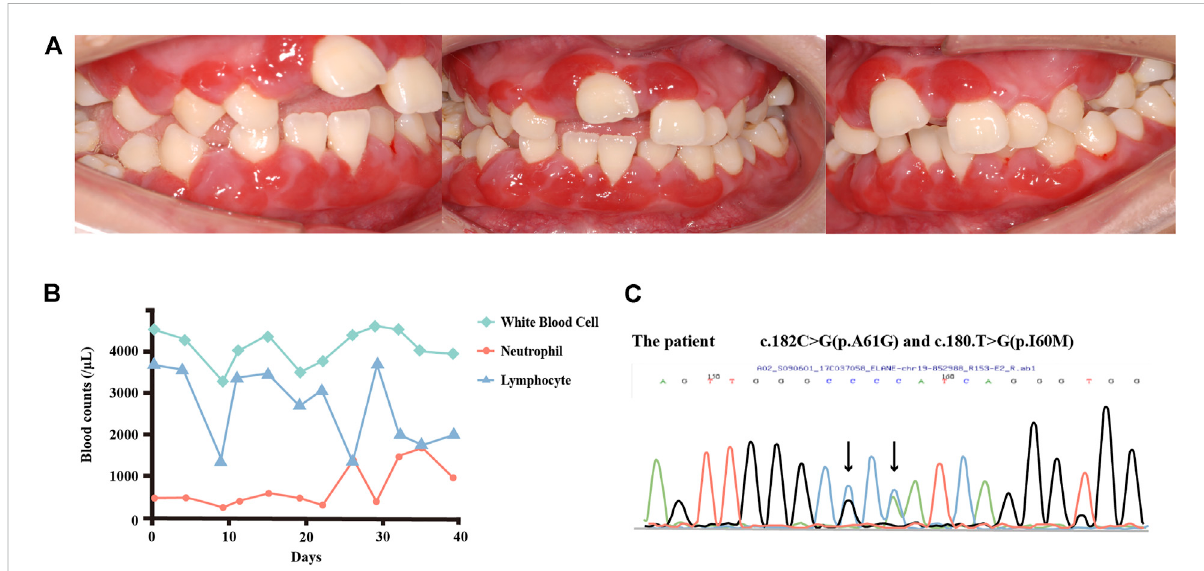
FIGURE 1 (A) Intraoral view of thepatient in2017. The marginal andattachedgingiva were fi eryred,with swelling and bleeding on contact. (B) Changes in the white blood cell, neutrophil, and lymphocyte counts over 6 weeks. The patient ’ s neutrophil counts appeared to cycle between 200/ μ L and 1,500/ μ L, with the lymphocyte counts showing an inverse cycle pattern. (C) DNA sequence analysis of ELANE . The patient carries two spontaneous mutations. As both forward andreversesequencescan beused for veri fi cation inSanger sequencing, thebases inthepeak diagram may bethe reverse complementary sequence of the detected bases. For instance, in c.180T > G, T > G is shown as A > C in the peak